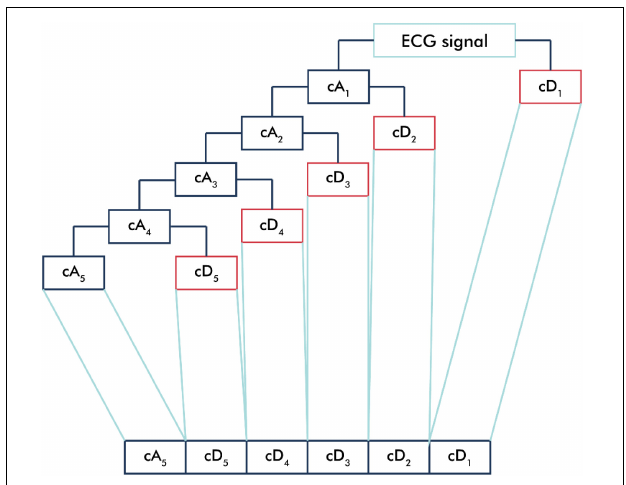
FIGURE 2 | One-dimensional wavelet decomposition. The ECG signal is passed into the low-pass filter (LPF) to produce an approximation component (cA) and is passed into the high-pass filter (HPF) to produce a detailed component (cD). In one-dimensional wavelet decomposition, five-level decomposition generated six sub-bands, which comprised one cA and five cD